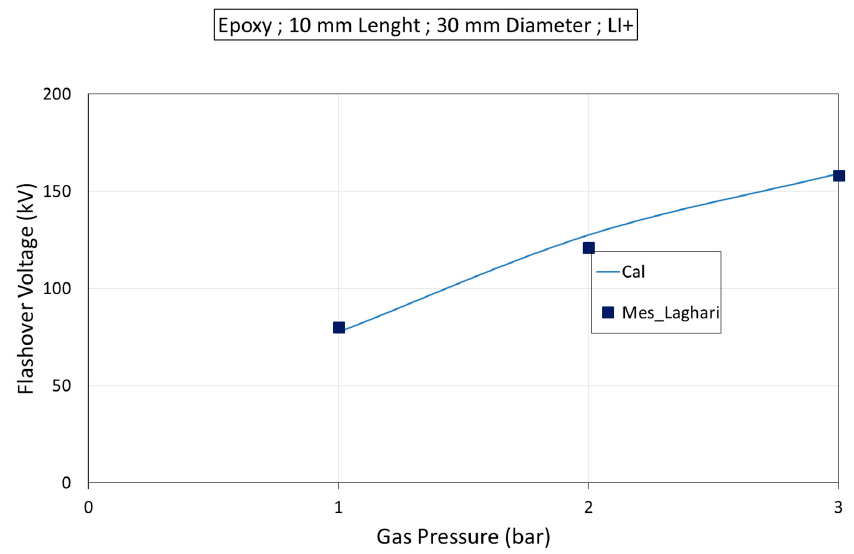
Figure 13. Comparison between calculated and measured flashover voltage versus gas pressure for a cylindrical epoxy insulator with 10 mm length and 30 mm diameter.